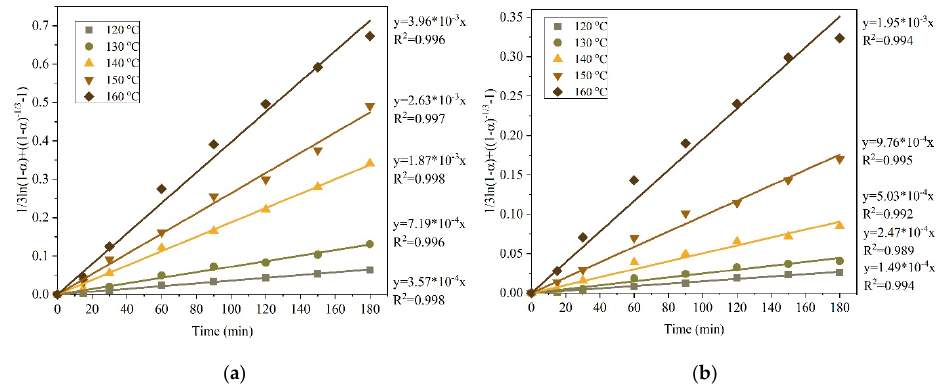
Figure 7. Dependence of 1 / 3ln(1 – α + ((1 − α ) − 1 / 3 − 1) on time for Cu ( a ) and Ag ( b ) recovery into solution.